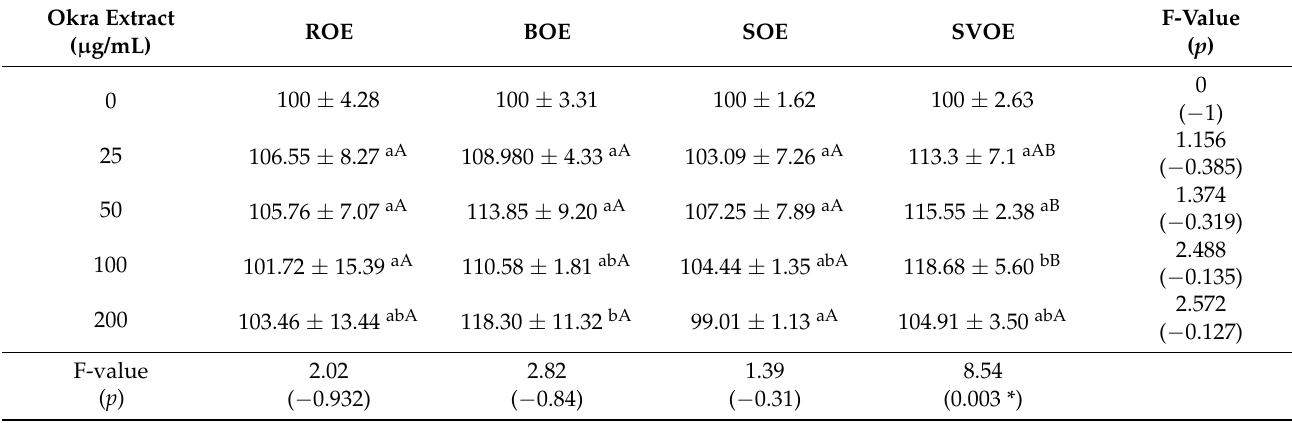
Table 1. Effect of raw okra ethanol extract (ROE), blanched okra ethanol extract (BOE), steamed okra ethanol extract (SOE), and sous-vide cooked okra ethanol extract (SVOE) on cell viability in lipopolysaccharide (LPS)-treated RAW264.7 cells.